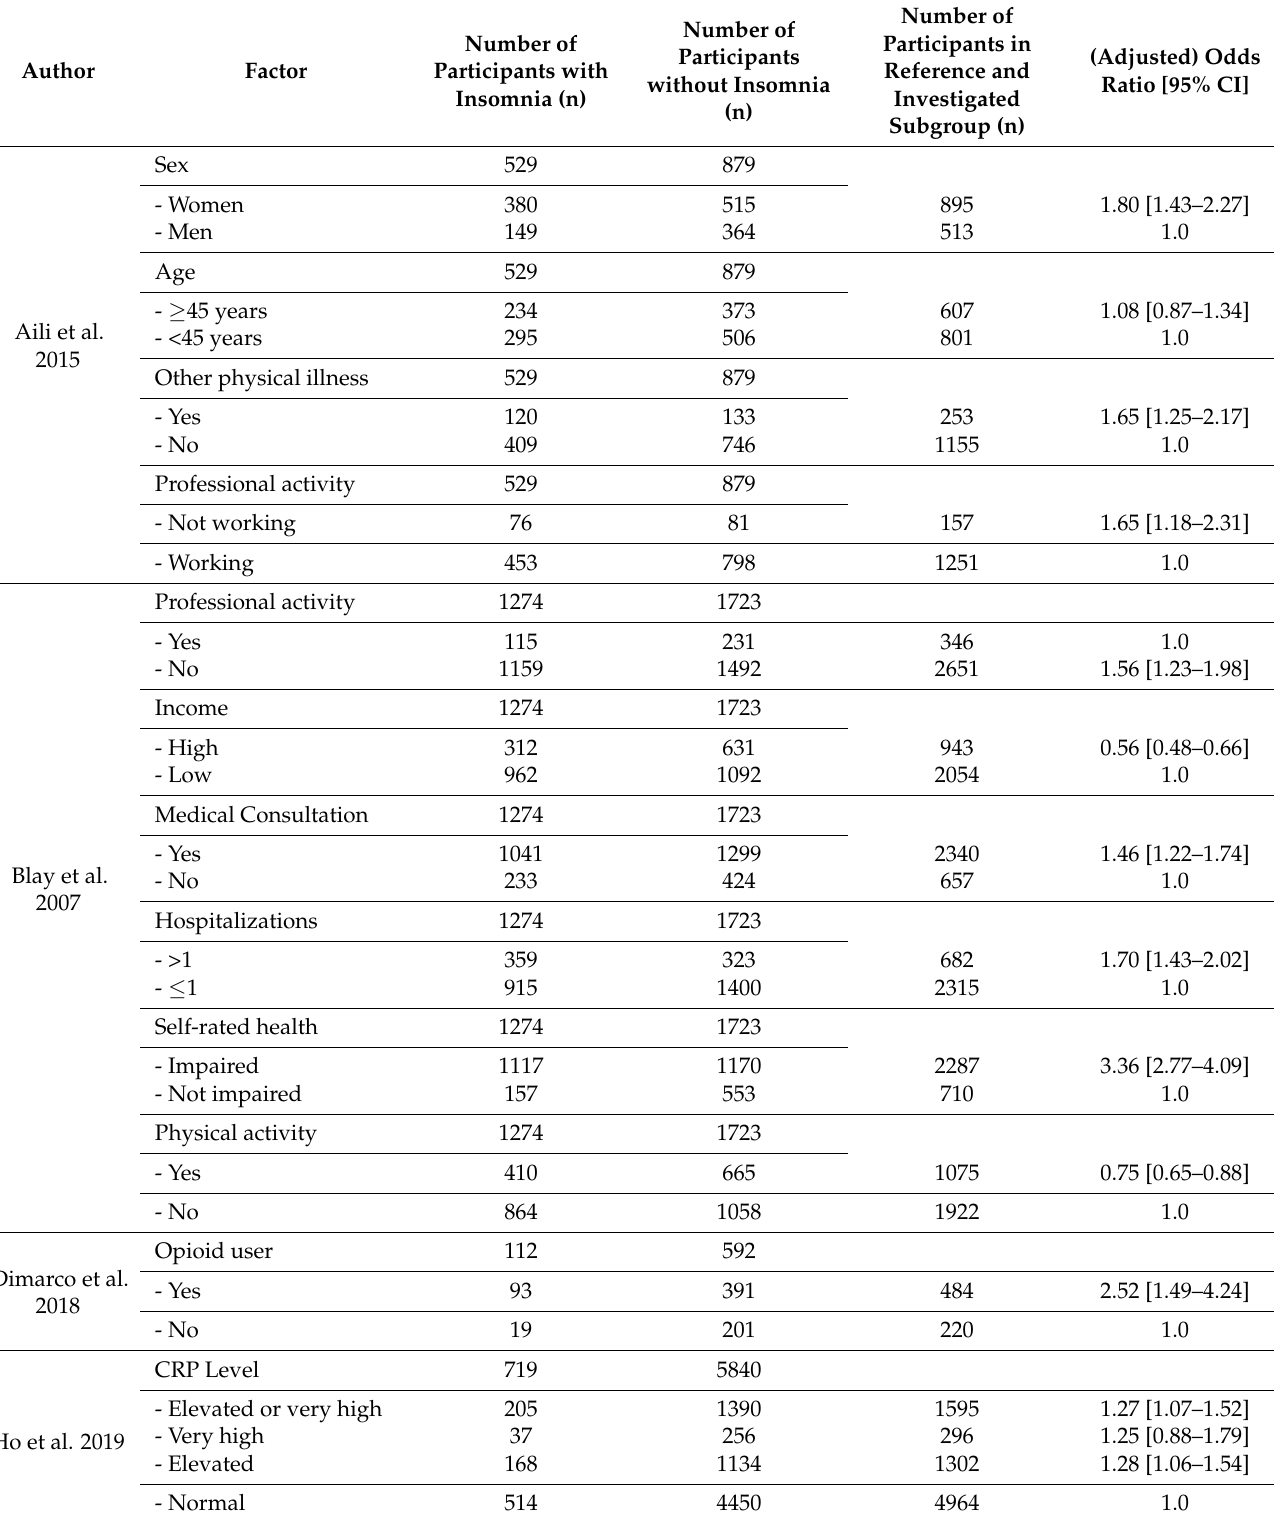
Table 3. Overview of included studies with the potential associates and related odds